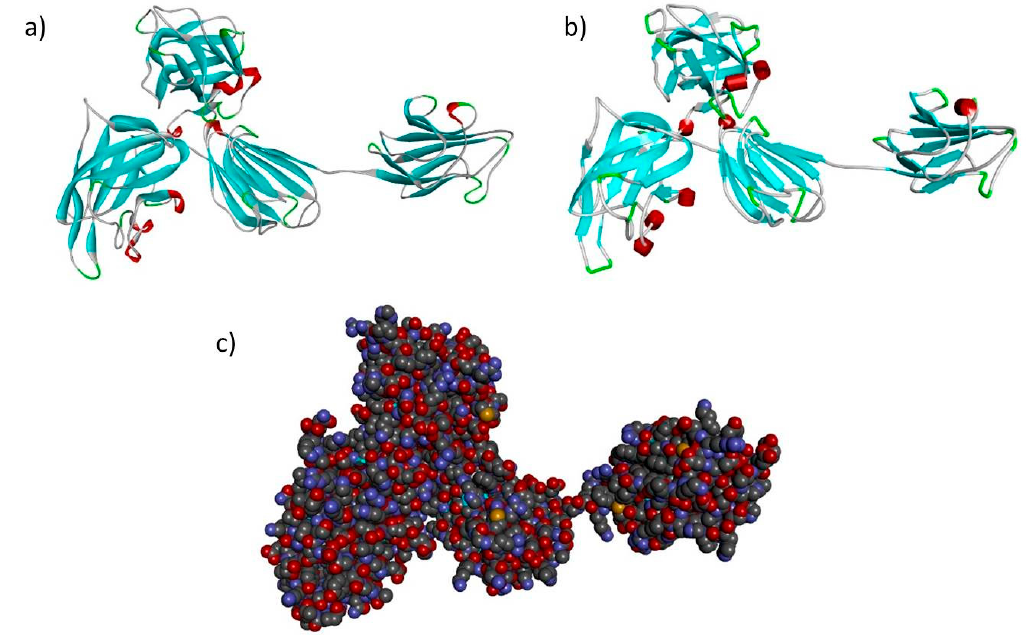
Figure 4. Modeled structure of the NRP1 gene in ( a ) ribbon ( b ) schematic and ( c ) CPK views. Cyan regions are β sheets, white represents loops and red represents α helices.